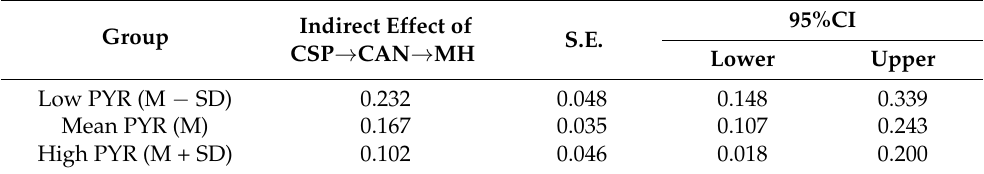
Table 9. High and low groupings of mediating effects with